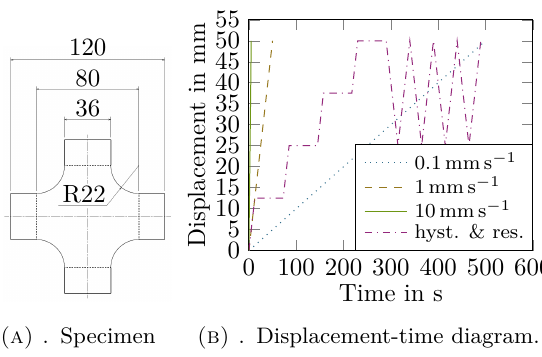
Figure 1. Biaxial test specimen with dimensions in mm and displacement-time diagram for 0 . 1 mm s − 1 , 1 mm s − 1 , 10 mm s − 1 and with the procedure including hystereses and relaxation for the